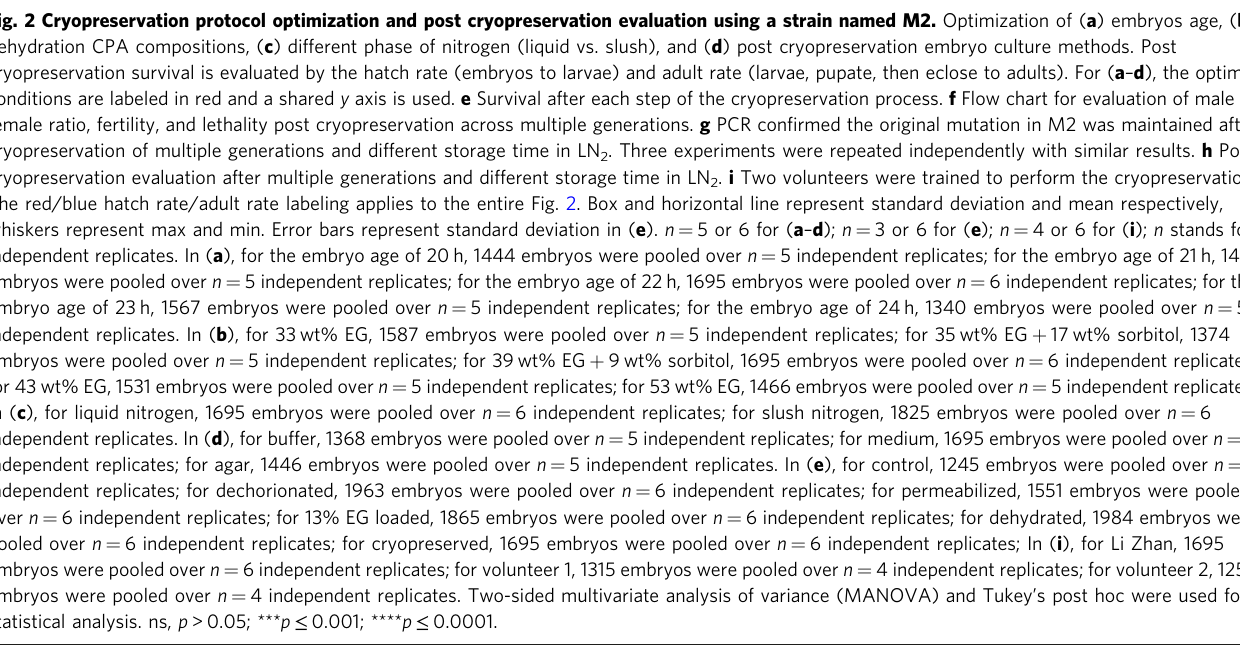
Fig. 2 Cryopreservation protocol optimization and post cryopreservation evaluation using a strain named M2. Optimization of ( a ) embryos age, ( b ) dehydration CPA compositions, ( c ) different phase of nitrogen (liquid vs. slush), and ( d ) post cryopreservation embryo culture methods. Post cryopreservation survival is evaluated by the hatch rate (embryos to larvae) and adult rate (larvae, pupate, then eclose to adults). For ( a – d ), the optimal conditions are labeled in red and a shared y axis is used. e Survival after each step of the cryopreservation process. f Flow chart for evaluation of male to female ratio, fertility, and lethality post cryopreservation across multiple generations. g PCR con fi rmed the original mutation in M2 was maintained after cryopreservation of multiple generations and different storage time in LN 2 . Three experiments were repeated independently with similar results. h Post cryopreservation evaluation after multiple generations and different storage time in LN 2 . i Two volunteers were trained to perform the cryopreservation. The red/blue hatch rate/adult rate labeling applies to the entire Fig. 2. Box and horizontal line represent standard deviation and mean respectively, whiskers represent max and min. Error bars represent standard deviation in ( e ). n = 5 or 6 for ( a – d ); n = 3 or 6 for ( e ); n = 4 or 6 for ( i ); n stands for independent replicates. In ( a ), for the embryo age of 20 h, 1444 embryos were pooled over n = 5 independent replicates; for the embryo age of 21 h, 1431 embryos were pooled over n = 5 independent replicates; for the embryo age of 22 h, 1695 embryos were pooled over n = 6 independent replicates; for